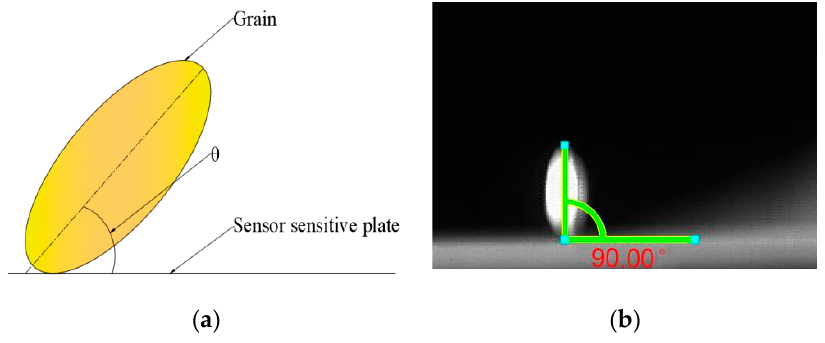
Figure 3. Collision angle between grain and sensitive plate.